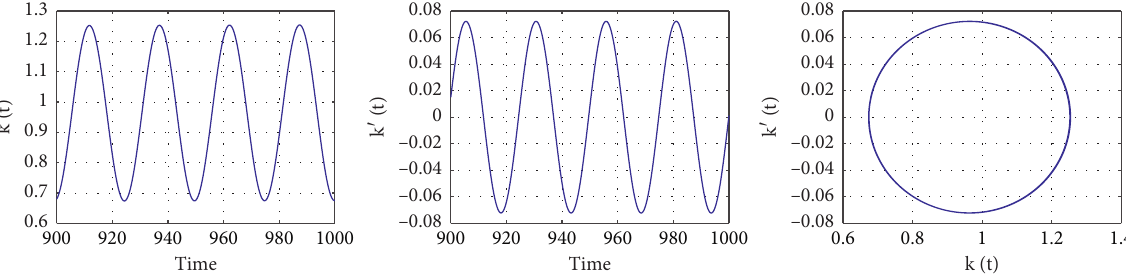
Figure 4: The birth of Hopf-bifurcated limit cycle from the fixed point k ∗ for the studied case when q � 0 . 5.